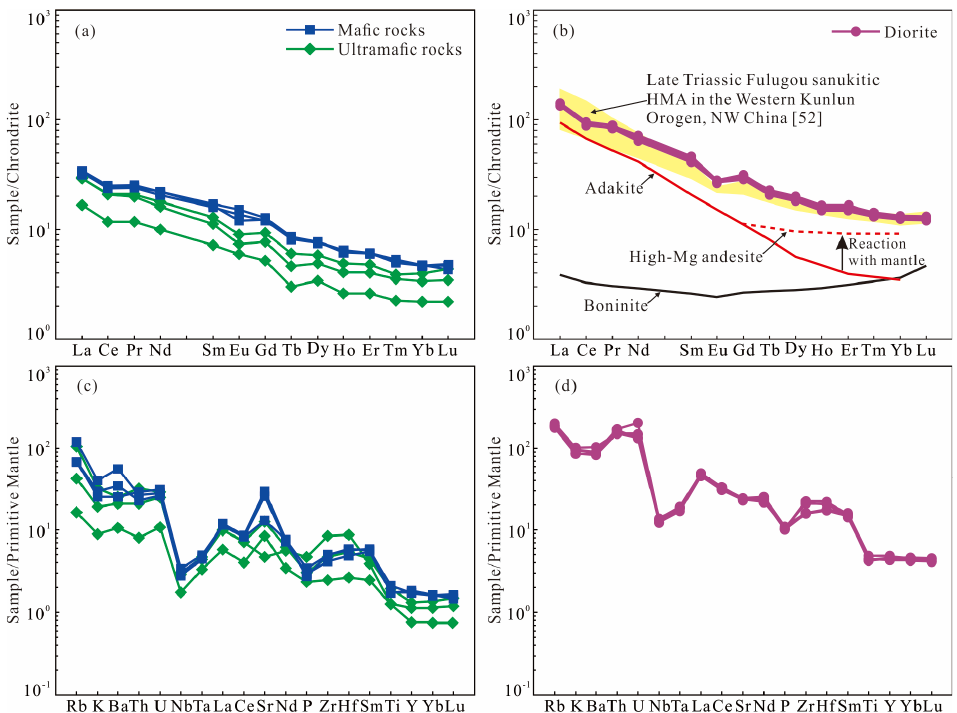
Figure 7. Chondrite-normalized REE distribution patterns (chondrite REE values from [50]) of the ( a ) mafic–ultramafic rocks and ( b ) diorites and primitive mantle-normalized trace-element patterns (primitive mantle values from [51]) of the ( c ) mafic–ultramafic rocks and ( d ) diorites. The data of Fulugou sanukitic high-Mg andesite (HMA) in the Western Kunlun Orogen were cited from [52]. The data of boninite were cited from [53], and the remainder data were cited from [54]. 5.2. Zircon U ‒ Pb Dating Despite the different shapes and internal structures, all the analyzed zircon from gab ‐ bro show similar Th/U ratios and 206 Pb/ 238 U ages (Table S3). Their Th/U ratios range from 0.12 to 1.56, but most of them are greater than 0.40, showing a diagnosis of magmatic zircon. They all plot on or near the concordia line, and their 206 Pb/ 238 U ages are concen ‐ trated within 224 ± 2 − 216 ± 2 Ma, with a weighted mean average age of 220 ± 1 Ma (MSWD = 2; n = 27) (Figure 8a), corresponding to the Late Triassic. Zircon from diorite have Th/U values of 0.36–1.00, with a majority of them exceeding 0.40 (Table S3), corresponding to magmatic zircon. They plot on the concordia line, and their 206 Pb/ 238 U ages range from 225 ± 3 Ma to 217 ± 2 Ma, with a weighted mean average age of 222 ± 1 Ma (MSWD = 1; n = 22) (Figure 8b).